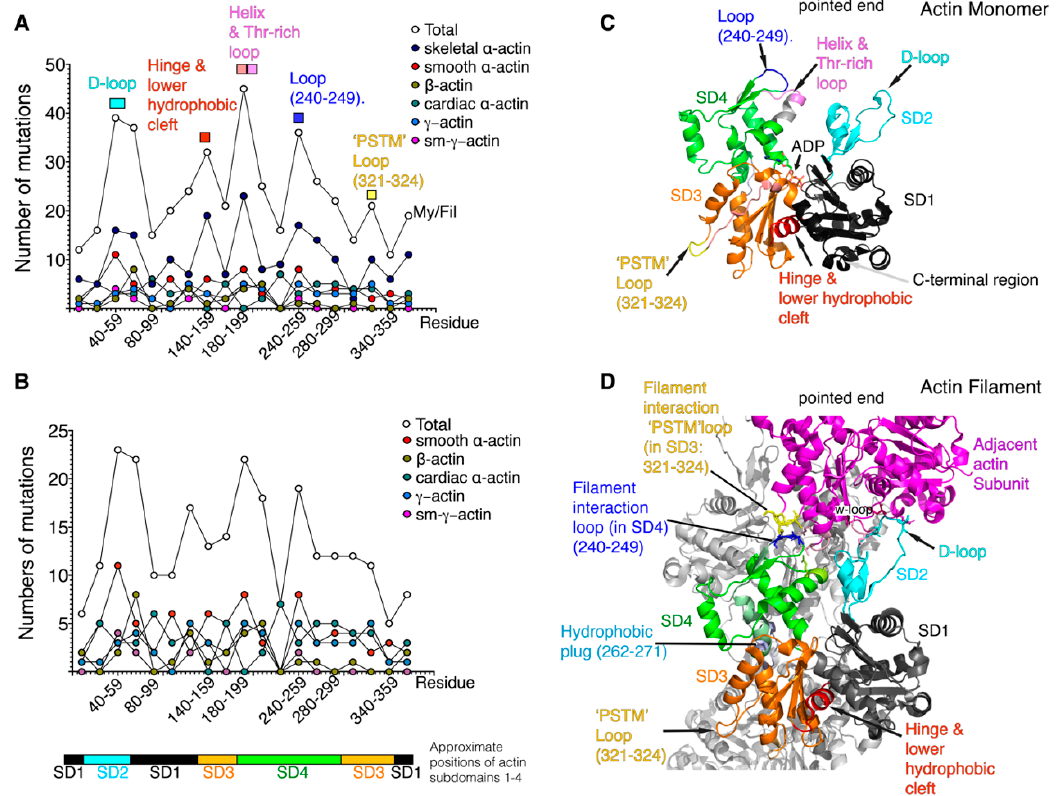
Figure 2. Analysis of actin mutations in all six Homo sapiens actin isoforms. Numbers of mutations in residues 1–19, 20–39 and so on, were summed and plotted as shown across the whole sequence for each individual isoform and for all isoforms (Total). ( A ) Panel A shows this analysis for each six actin isoforms, and the total for all six. The protein names are shown in the key. ( B ) Panel B is similar to A, except the mutations for ACTA1 were excluded. Mutations were taken from the HGMD (accessed November 2019, Supplementary Table S1). The approximate positions of the four subdomains found in the G-actin monomer ( C ) is additionally shown underneath panels A and B for reference. ( C ) The G-actin monomer is made up of four subdomains (denoted by black (subdomain-1, SD1), cyan (subdomain-2, SD2) orange (subdomain-3, SD3) and green (subdomain-4, SD4). Labels indicate regions of the structure that are hotspots for mutations. ( D ) The F-actin filament. One actin monomer is shown as in C, with the SD1-4 in black, cyan, orange and green, respectively. Positions where mutations are common are highlighted. The interaction between residues 243–245 in in SD4 (coloured blue), with residues 322–325 in SD3 (coloured yellow) in the adjacent actin subunit (coloured magenta) is indicated. Longitudinal contacts between the DNAse-1 loop (or D-loop; 38-52) and residues in the C-terminal region of the adjacent monomer (residues R372, F375), Pro-rich and w-loops are also shown. The helix coloured red (residues 135–146) in D is found in the lower hydrophobic cleft. The hydrophobic plug (residues 262–272, light blue) is important for lateral actin monomer contact between protofilaments. The regions of sequence for each subdomain have been defined as follows SD1 (residues 1–32, 70–144, and 338–372), SD2 (residues 33–69) SD3 (residues 145–180 and 270–337) SD4 (residues 181–269) [33].